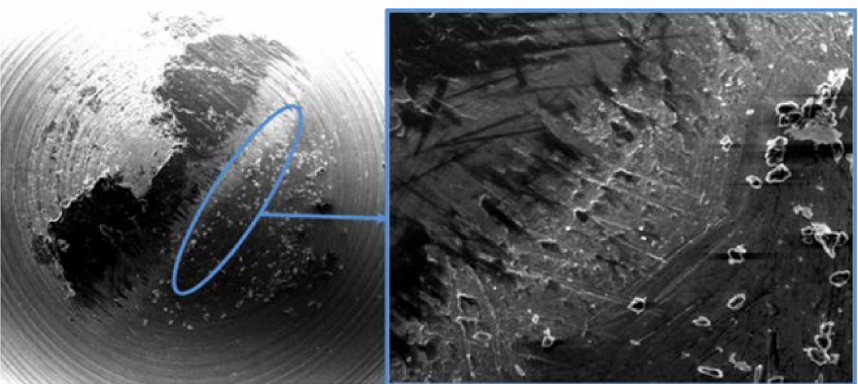
Figure 9. SEM (90 × ) micrography of the pin for test condition 900 m sliding distance. Detail of the abrasion produced by particles drag (600 ×